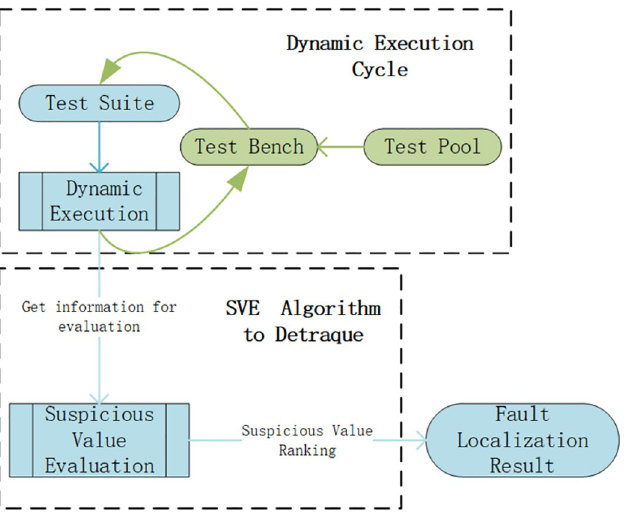
Fig 1. Workflow of Detraque. The workflow of Detraque is depicted in the figure. Divided into two main modules, one is the Dynamic Execution Cycle , the function is to execute the program through the Test Bench and collect the dynamic execution information of the program. The other part is the SVE Algorithm to Detraque , whose function is to calculate the suspicious value of the statement based on the information output in the Dynamic Execution Cycle . Finally, obtain the final fault localization result based on the suspicious value.